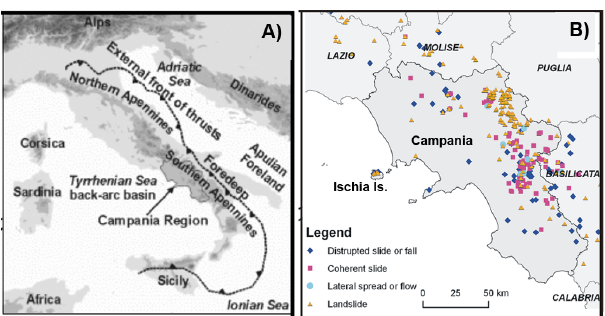
Fig. 6. Location of the Campania region within the Italian territory (A) and of the Ischia Island. (B) The seismic-induced landslides considered in the analysis are shown in plot (B) . Modified after Rapolla et al.